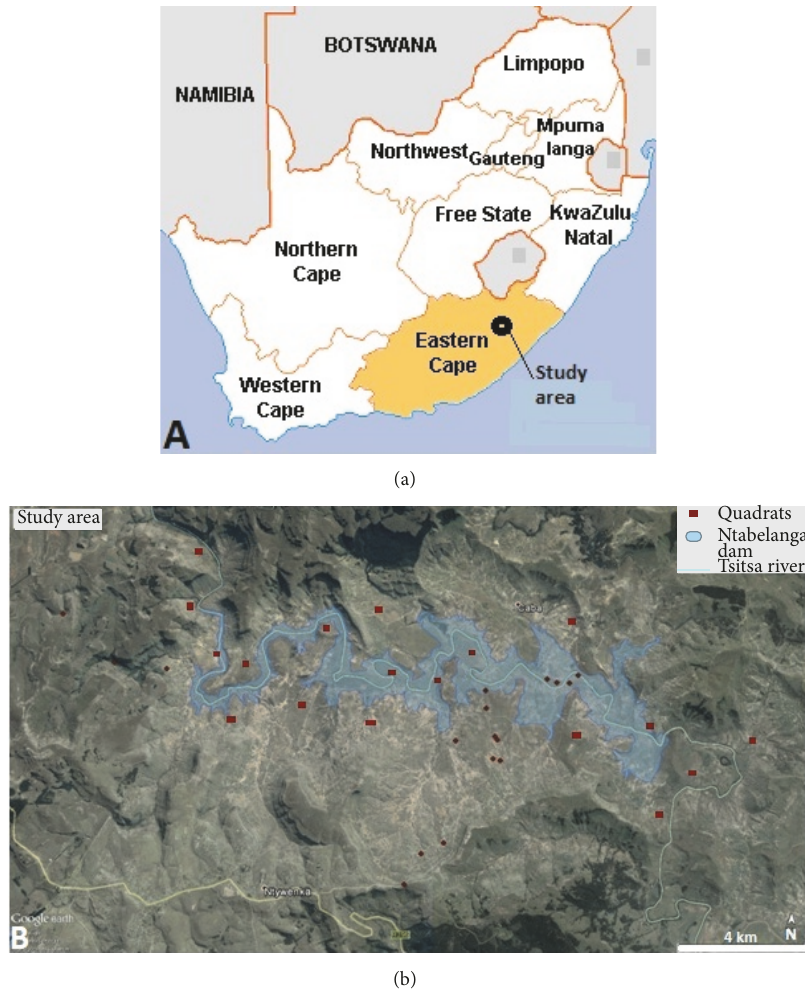
Figure 1: Geographical location of the study area. (a) Map of South Africa illustrating the geographical position of Ntabelanga dam in the Eastern Cape province and (b) detailed map showing position of quadrats along the Tsitsa